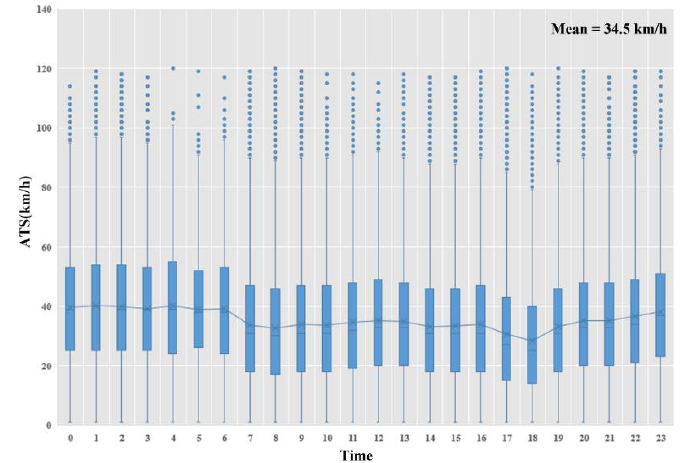
Figure 7. Average travel speed of taxis( ATS taxi ) of all RSBs.